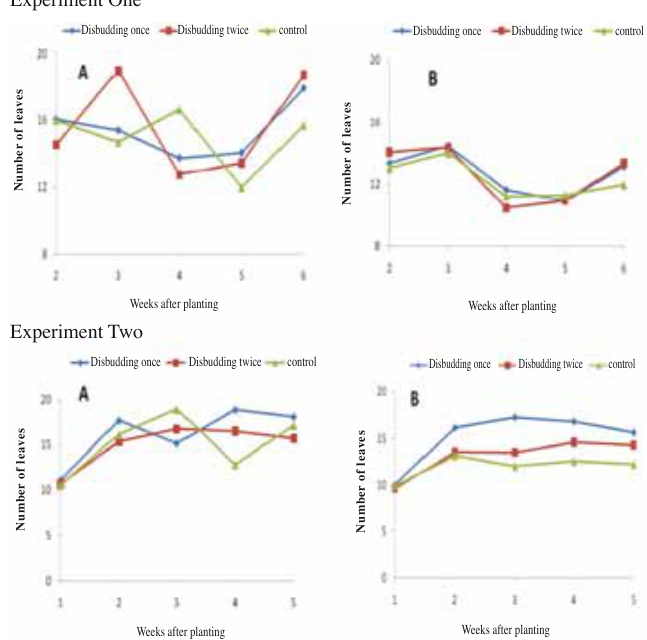
Fig. 4 - Leaf growth as influenced by disbudding and cultivar: ‘Carmi - ne’ (A) and ‘Chief Gold’ (B) cultivars of celosia.